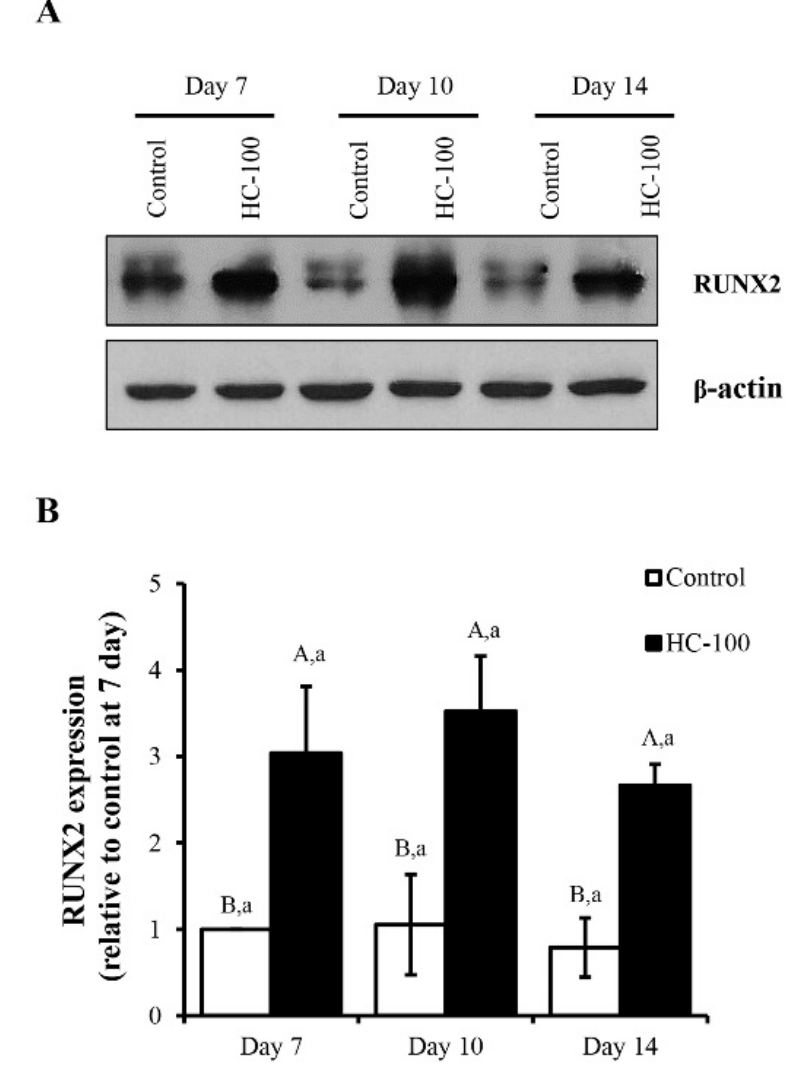
Figure 5. Effect of sea bass skin hydrolyzed collagen (HC) at 100 µg/mL on ( A ) expression level of RUNX2 in MC3T3-E1 cells after differentiation for 7, 10 and 14 days; ( B ) results are expressed as relative values to control at day 7. Error bars represent standard deviation ( n = 3). Different uppercase letters indicate significant differences between samples at the same culture time ( p < 0.05). Different lowercase letters indicate significant differences between culture times of the same sample ( p < 0.05).